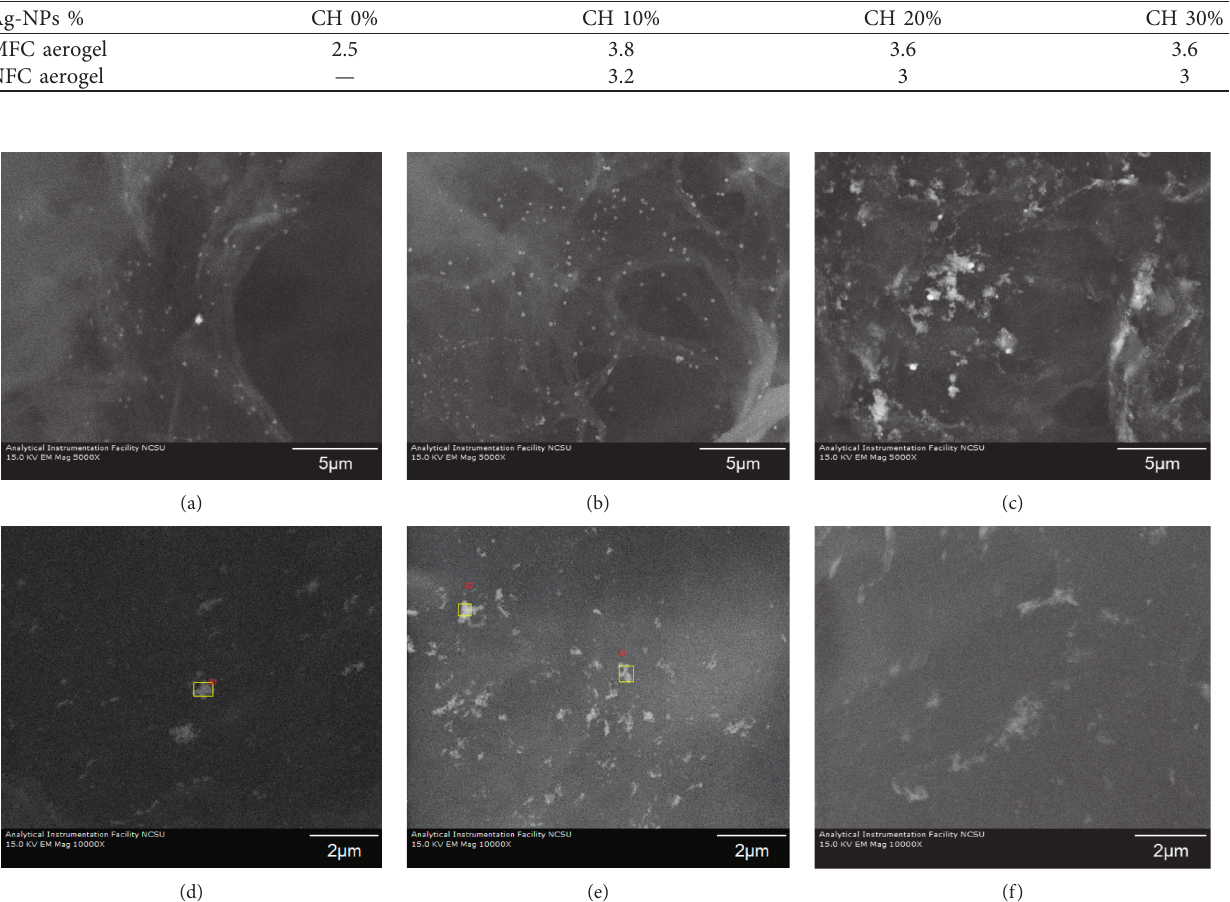
Table 3: Ag-NP content in MFC/NFC aerogels.